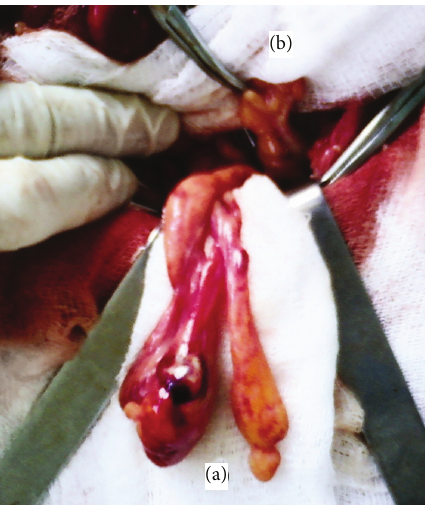
Figure 1: A view of the operating field in the right inguinal area: a two-tailed epiploic appendage of the sigmoid colon with the signs of necrosis (a) and a normal vermiform appendix (b).